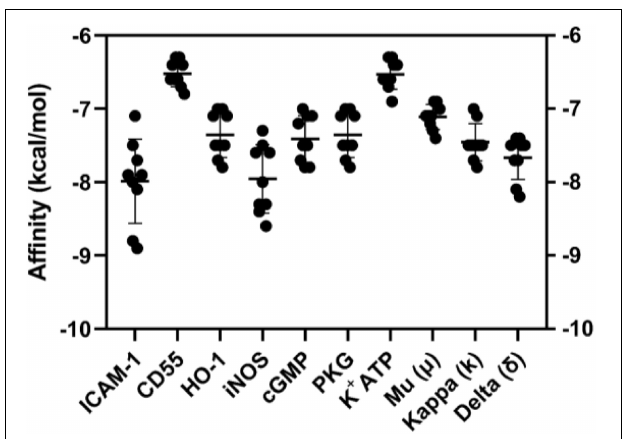
FIGURE 1 | Graphical representation (means ± SD) of binding energy values of molecular dockings between MC-H and ICAM-1, CD55, HO-1, iNOS, soluble cGMP, cGMP-dependent protein kinase (PKG), K + ATP channel, mu ( µ ), kappa (k), and delta ( δ ) opioid receptors. AutoDock Vina was employed to calculate the affinity values